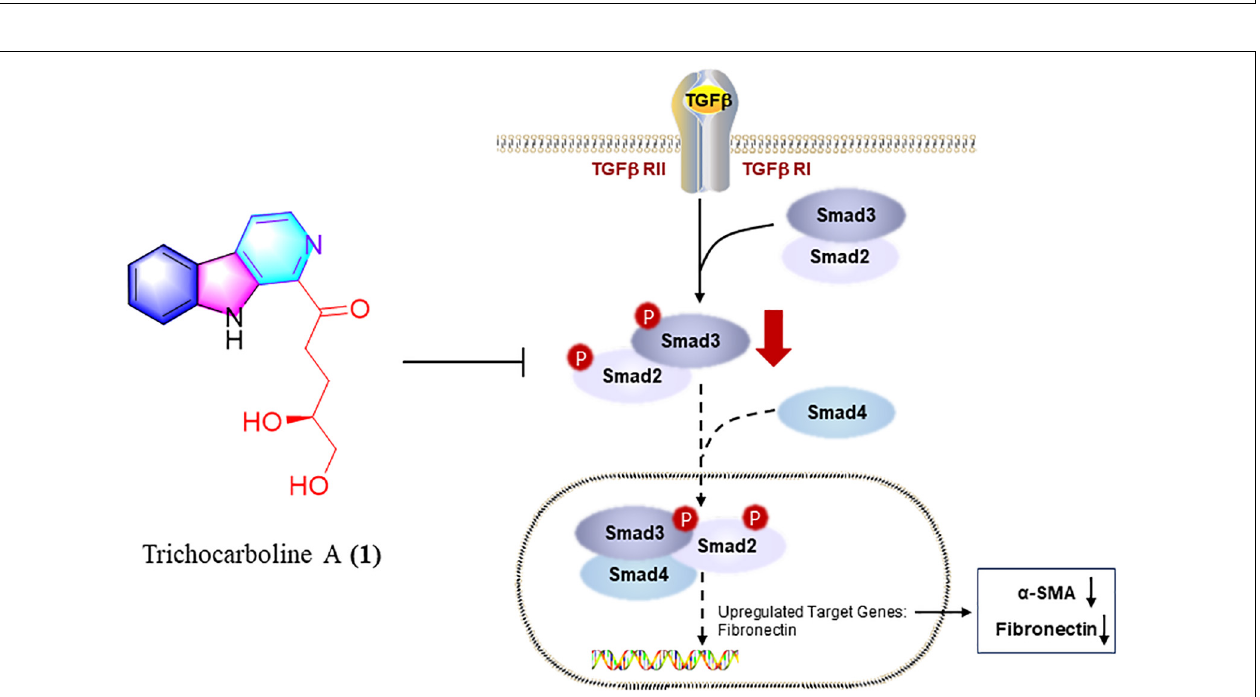
FIGURE 6 | Trichocarboline A ( 1 ) suppressed the phosphorylation of Smad2/3 in TGF- β /Smad signaling. Trichocarboline A ( 1 ) was a TGF- β /Smad signaling inhibitor, making it a promising lead compound for the development of agents to treat pulmonary fibrosis disease.